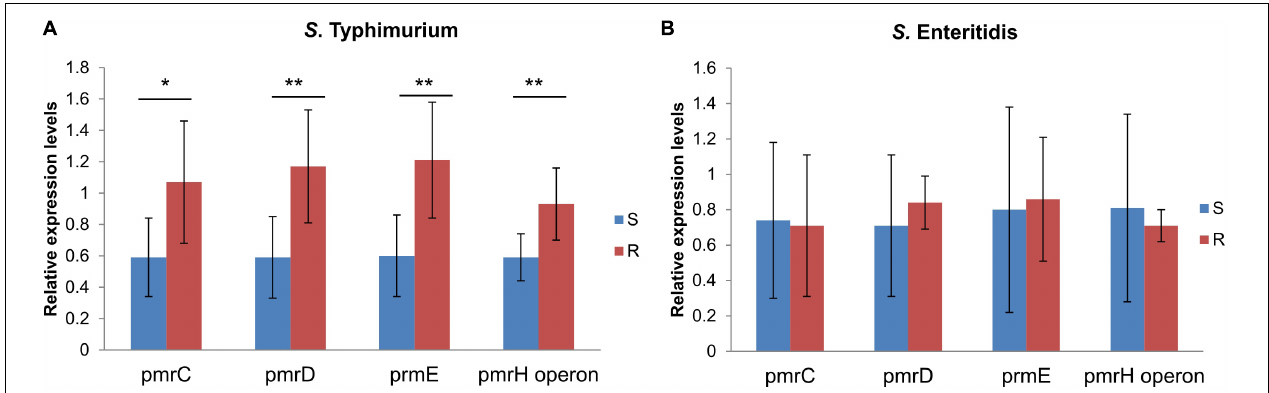
FIGURE 5 | Relative expression levels of pmrC , pmrD , pmrE and pmrHFJKLM operon in colistin resistant and sensitive isolates of serotype Typhimurium (A) and Enteritidis (B) . Gene expression levels of each target gene were identified and compared with 16s rRNA expression levels of each isolates. Relative gene expression levels of colistin sensitive (S) group and colistin resistant (R) group in serotype Typhimurium and Enteritidis were compared using p -values calculated by Statistical Package for the Social Sciences (SPSS) using rank-sum tests, respectively (* P < 0.05, ** P < 0.01).